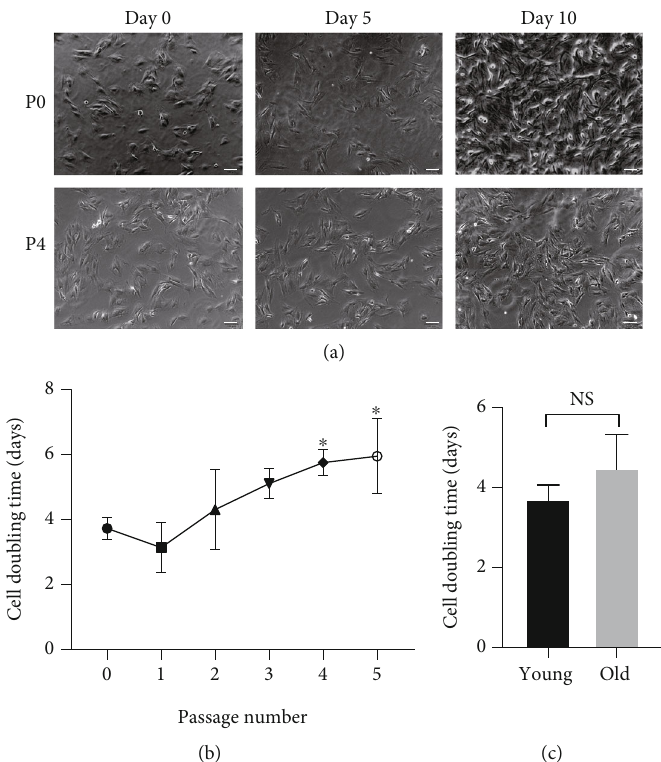
Figure 1: Changes in the morphology and proliferative activity of MSCs subjected to senescence induction. (a) Representation of morphological changes in primary MSCs (P0) and ageing P4 MSCs in vitro. Bright- fi eld images of MSCs at P0 and P4 (captured on days 0, 5, and 10) showing that there were more proliferating P0 MSCs than P4 MSCs. Scalebars = 100 μ m . (b) The reduction in proliferative capability was quanti fi ed by the MSC population doubling time, which showed a gradual increase with an increase in passage number. (c) However, primary MSCs from young animals and old animals did not show a di ff erence in MSC doubling time. The numbers represent the mean values. n = 4 ; Student ’ s t -test. ∗ p < 0 : 05 versus the corresponding P0 MSCs cultured under the same expansion